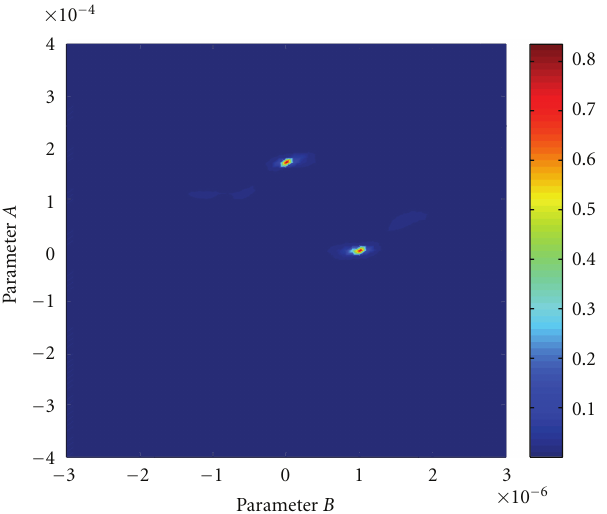
Figure 9: Correlated sources: Determination of parameters A and B based on MUSIC for a di ff ractor and a dipping reflector β = 20 0 . The black stars show the correct parameter locations.